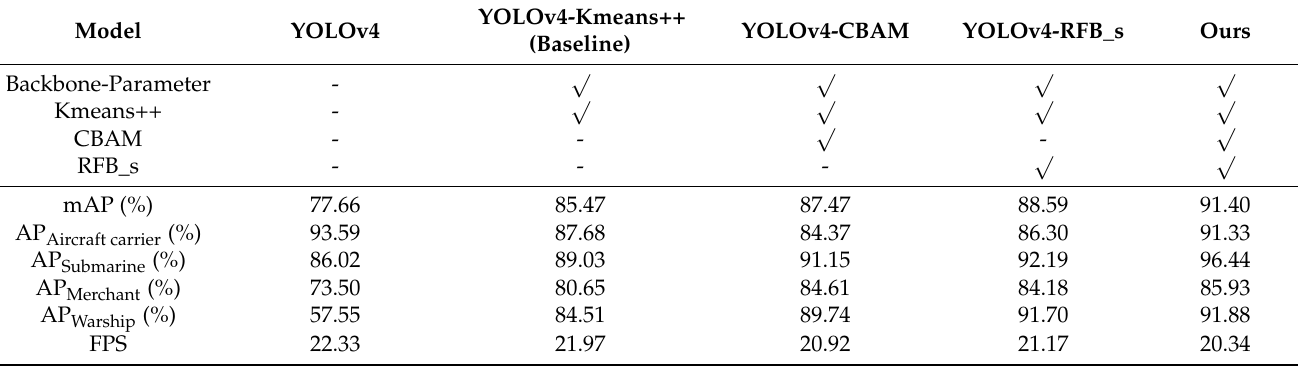
Table 5. Comparison of ablation